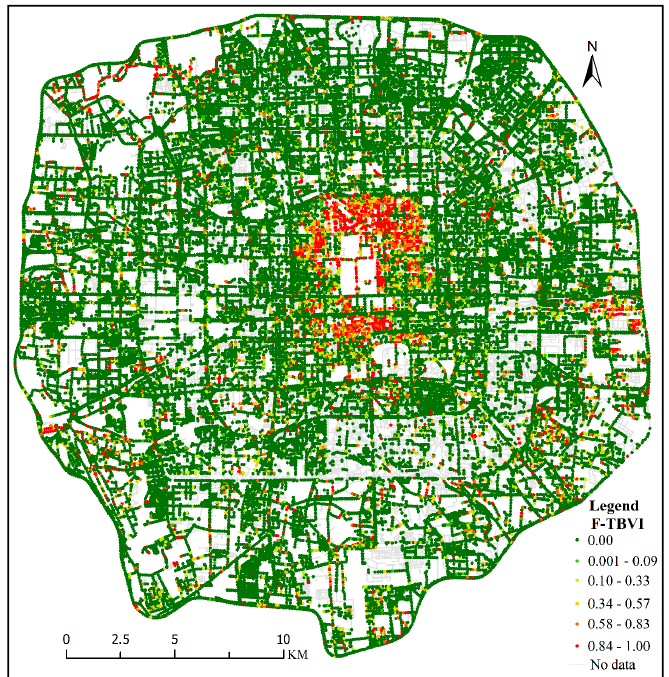
Figure 8. Spatial distribution of the TBVI of the folk-style buildings. Table 5. Moran’s I of the Chinese traditional-style buildings.